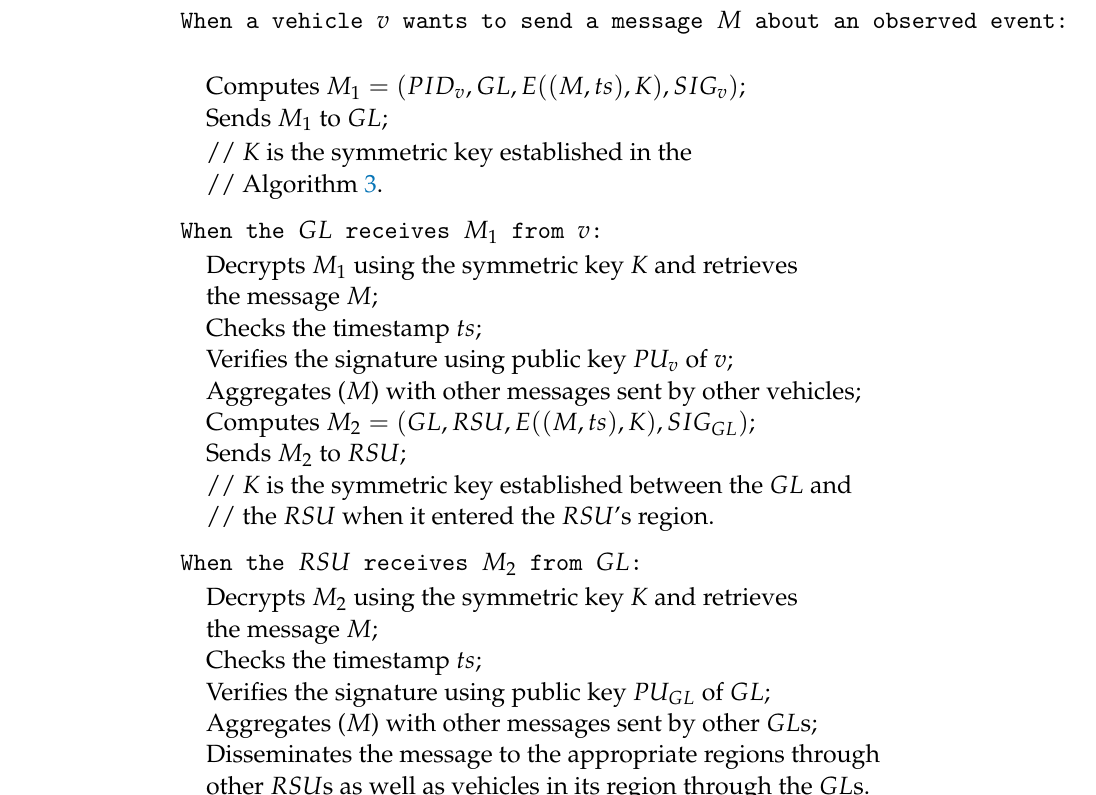
Algorithm 4: Vehicle v sending a Message M to its Group Leader